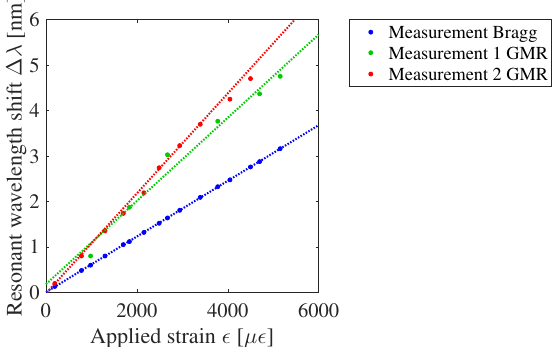
Figure 21. A picture and a schematic of the setup for strain measurements. The sensor foil contains two sensors: A GMR grating sensor and a waveguide Bragg grating sensor as reference sensor. PC = polarization controller.